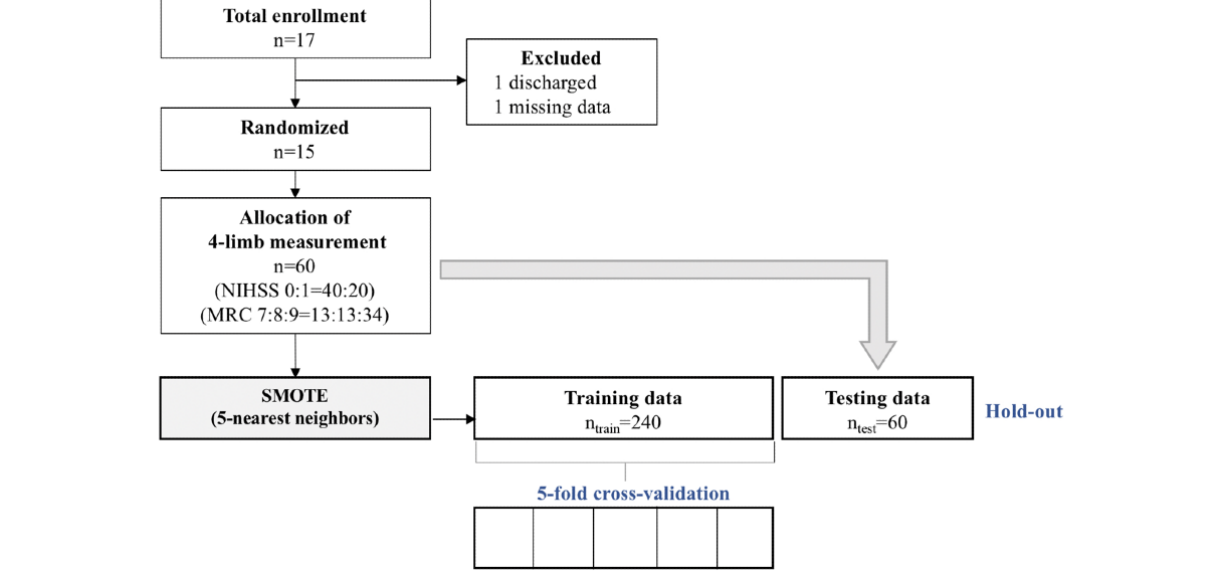
Figure 1. Patient enrollment and data set for automatic grading system. MRC: Medical Research Council; NIHSS: National Institutes of Health Stroke Scale; SMOTE: synthetic minority oversampling technique.